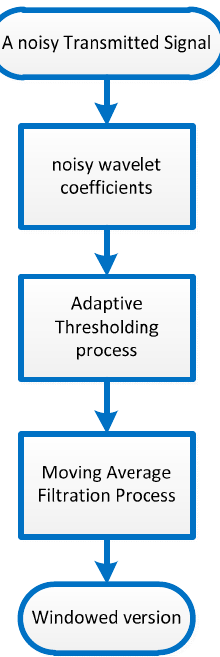
Figure 4. Flowchart of the W-DFT process.